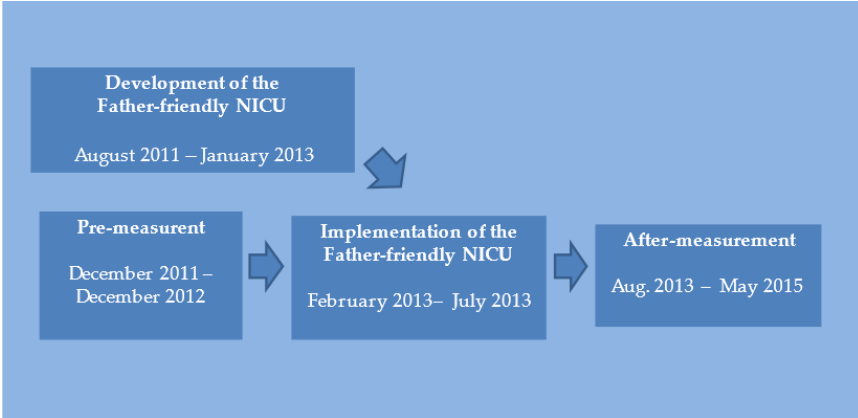
Figure 1. The timeframe of developing the father-friendly NICU.